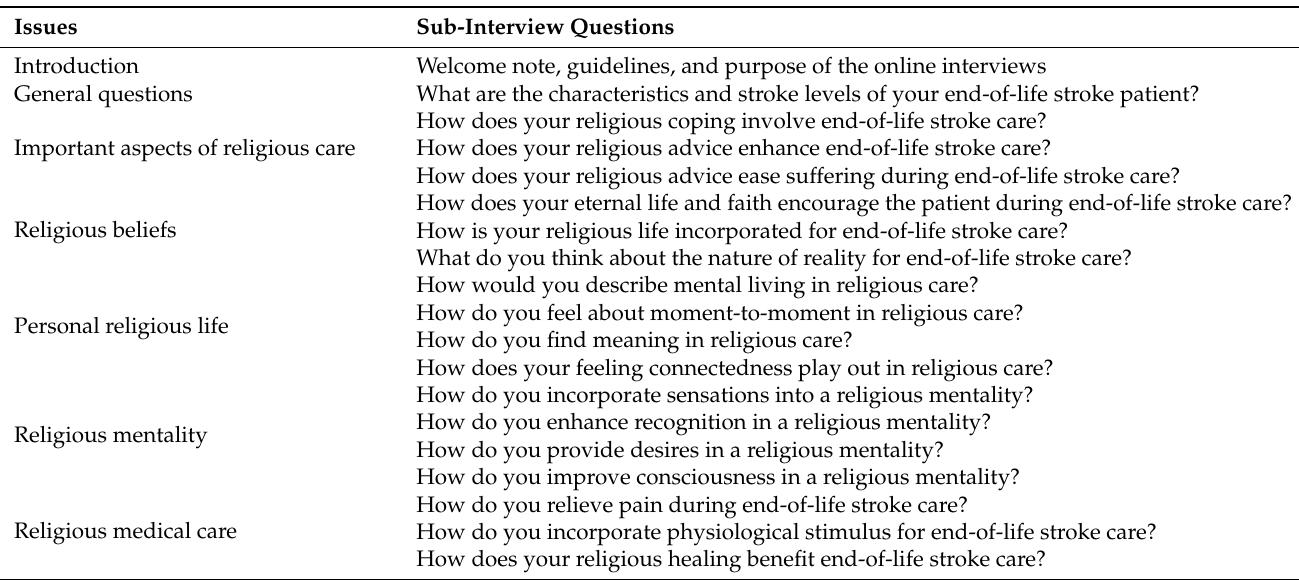
Table 1. Sample online in-depth interview